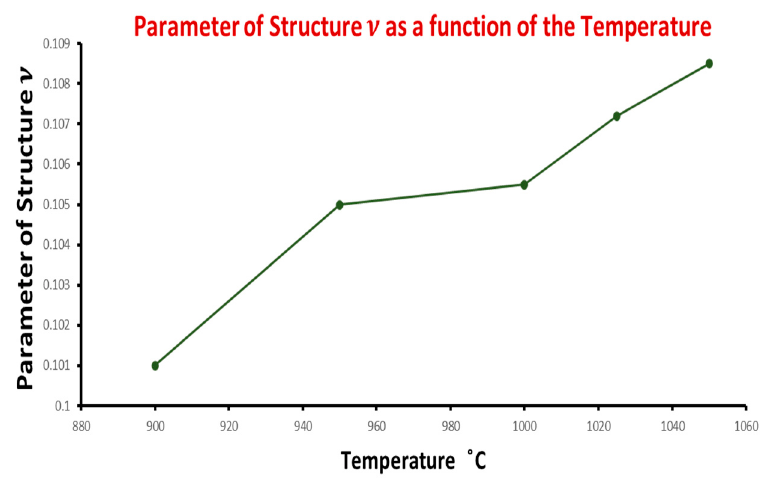
Figure 3. Sulfur–sulfur distance versus temperature.